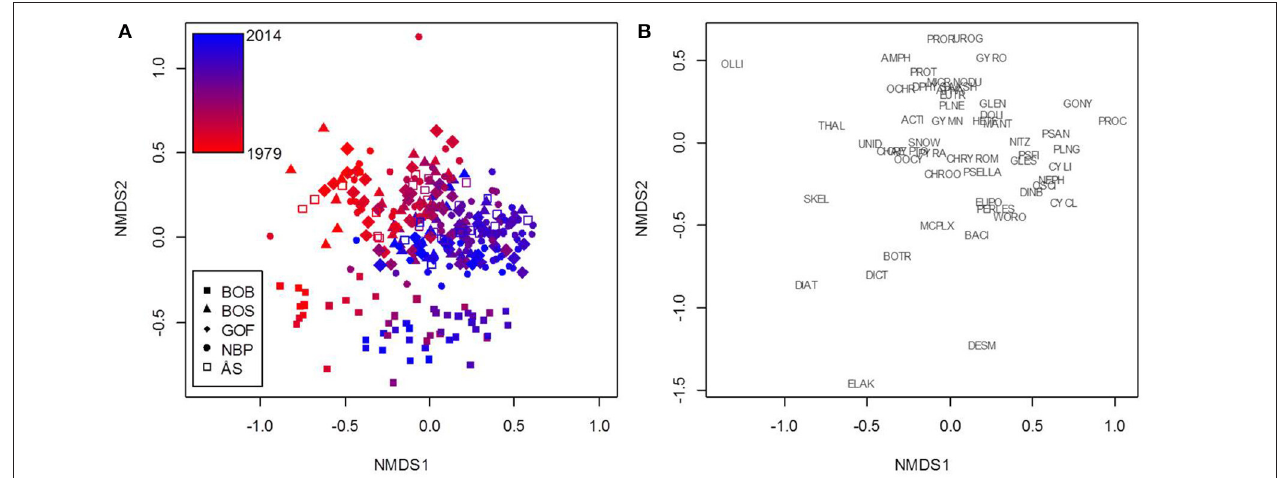
FIGURE 3 | A demonstration of the non-metric multidimensional scaling (NMDS) results based on northern Baltic Sea phytoplankton monitoring data. NMDS was used to cluster samples (A) based on genus-level biomass composition. The 53 genera (and orders and complexes) that the analysis is based on are plotted separately for clarity (B) . The color scale represents sampling years from 1979 (red) to 2014 (blue). The HELCOM sea areas investigated were BOB, Bothnian Bay; BOS, Bothnian Sea; GOF, Gulf of Finland; NBP, Northern Baltic Proper; ÅS, Åland Sea. Taxa: ACTI, Actinocyclus ; AKSH, Akashiwo ; AMPH, Amphidinium ; APHA, Aphanizomenon ; BACI, Bacillariales; BOTR, Botryococcus ; CHAE, Chaetoceros ; CHROO, Chroococcales; CHRYROM, Chrysochromulina ; CRYPTO, Cryptomonadales; CYCL, Cyclotella ; CYLI, Cylindrotheca ; DESM, Desmodesmus ; DIAT, Diatoma ; DICT, Dictyosphaerium ; DINB, Dinobryon ; DPHYS, Dinophysis ; DOLI, Dolichospermum ; ELAK, Elakatothrix ; EUPO, Eupodiscales; EUTR, Eutreptiella ; GLEN, Glenodinium ; GONY, Gonyaulax ; GLES, Gymnodiniales; GYMN, Gymnodinium ; GYRO, Gyrodinium ; HETE, Heterocapsa ; MANT, Mantoniella ; MICR, Micromonas ; MCPLX, Monoraphidium complex; NEPH, Nephroselmis ; NITZ, Nitzschia ; NODU, Nodularia ; OCHR, Ochromonadales; OLLI, Ollicola ; OOCY, Oocystis ; OSCI, Oscillatoriales; PERLES, Peridiniales; PLNE, Planctonema ; PLNG, Planktolyngbya ; PROC, Prochlorothrix ; PROR, Prorocentrum ; PROT, Protoceratium ; PSAN, Pseudanabaena ; PSELLA, Pseudopedinella ; PSFI, Pseudoscourfieldia ; PYRA, Pyramimonas ; SKEL, Skeletonema ; SNOW, Snowella ; THAL, Thalassiosira ; UNID, Unidentified monads and nanoflagellates; UROG, Uroglena ; WORO, Woronichinia .